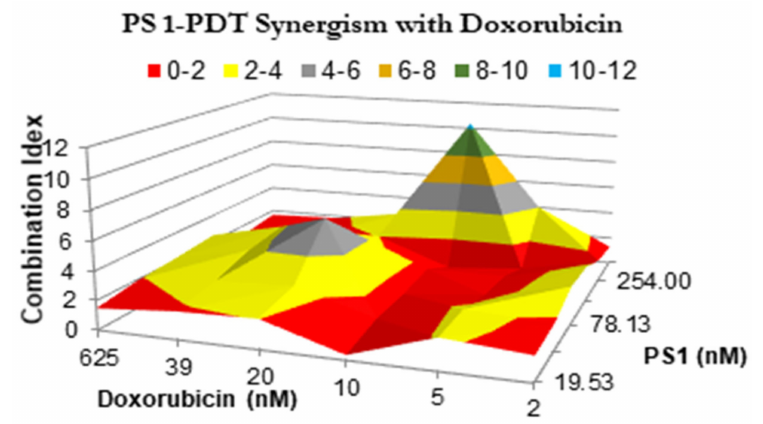
Figure 5. The synergism of PS 1 and doxorubicin were tested at varying drug doses. A549 cells were incubated with PS 1 . Cells were exposed to light (fluence: 1.0 J/cm 2 , fluence rate: 75 mW/cm 2 ) applied at 24 h post-incubation. Doxorubicin was then added at various concentrations, and cells were incubated for 48 h, then assessed for cytotoxic effects. The combination indices were calculated for each point using the formula CI = [E PS1 + E dox − E PS1 E dox ]/E PS1*dox . Therefore, the combination index plotted above represents the ratio between the hypothetical efficacy and the observed efficacy of the combination. Peaks indicate antagonism, values near 1.0 indicate an additive effect, and valleys indicate synergism.